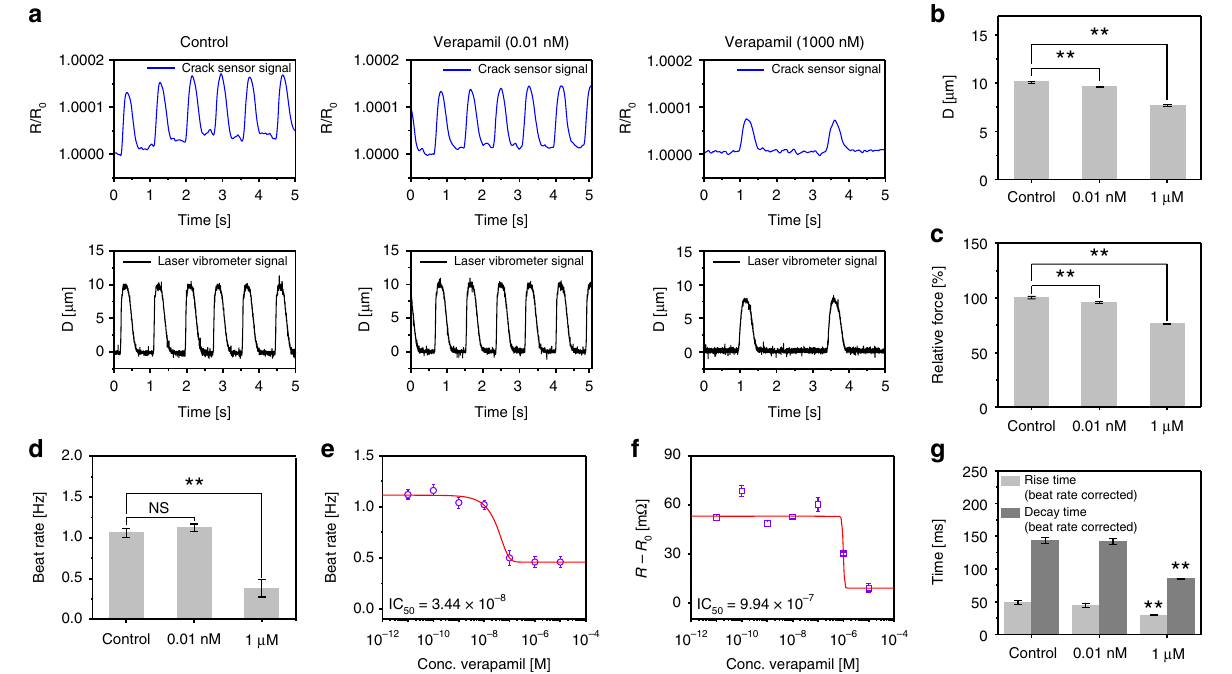
Fig. 6 Change in contractility of the verapamil treated cultured cardiomyocytes. a Representative real-time traces of change in sensor resistance ratio and cantilever displacement owing to the contraction and relaxation of different concentration of verapamil treated cardiomyocytes. b , c Bar plot depicting the cantilever displacement and relative contraction force generated by cardiomyocytes (** p < 0.01 measures by one-way ANOVA followed by Tukey ’ s honest signi fi cant difference test.). d Beat rate of cardiomyocytes at verapamil concentrations of 0.01 nM and 1 µ M. e Beat rate of verapamil treated cardiomyocytes at different concentrations (0.01 nM – 10 µ M). f Change in resistance of the cardiomyocytes seeded cantilever at different verapamil concentrations (0.01 nM – 10 µ M). g Rise time and decay time of cardiomyocytes at verapamil concentrations of 0.01 nM and 1 µ M. The rise time and decay time were analyzed and beat rate corrected with Fridericia ’ s formula (Rise time corrected (Rc) = R/interspike interval 1/3 ) and (Decay time corrected (Dc)